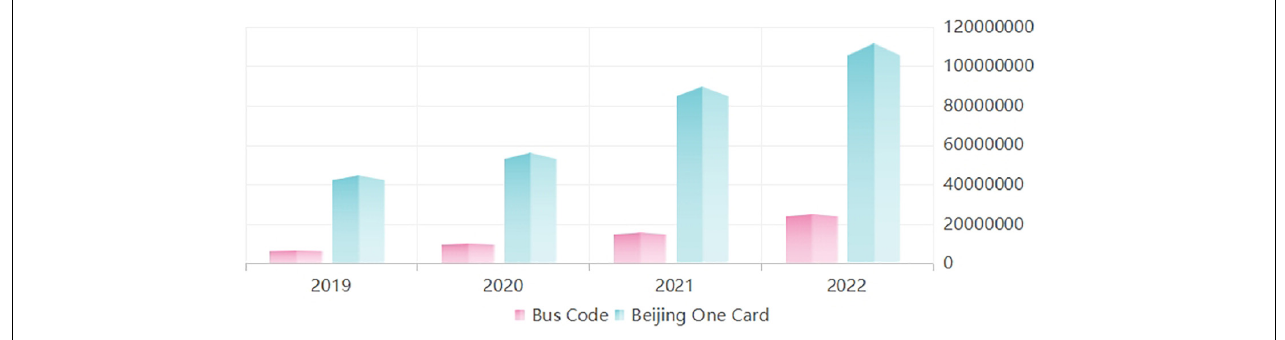
FIGURE 3 | Total downloads of “Beijing One Card” and “Bus Code” from 2019 to